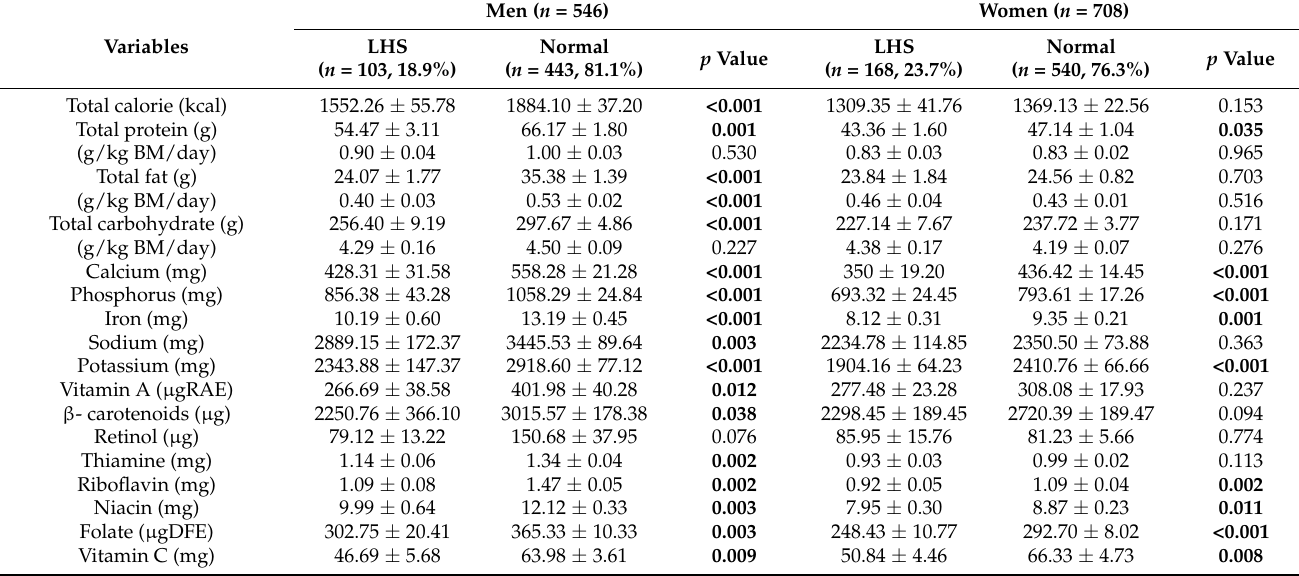
Table 2. Comparison of nutritional intake status of the participants in men and